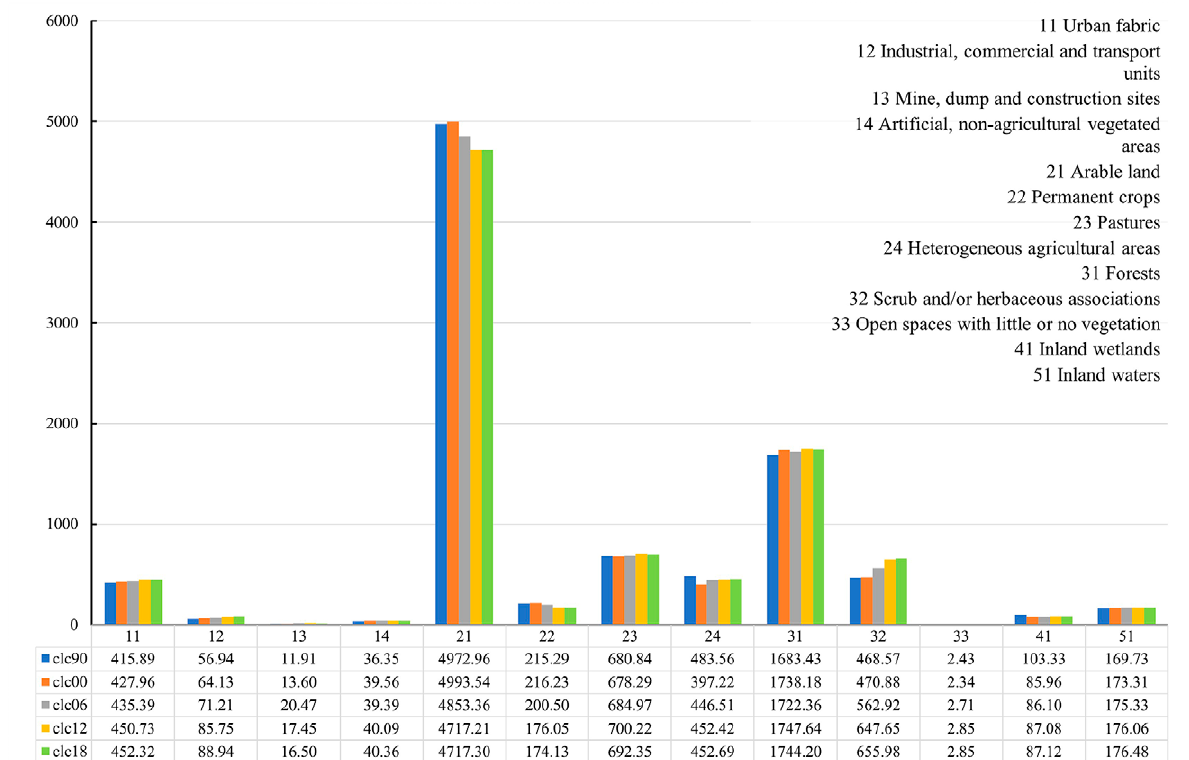
Figure 2. Distribution of CLC categories in Hungary in thousand